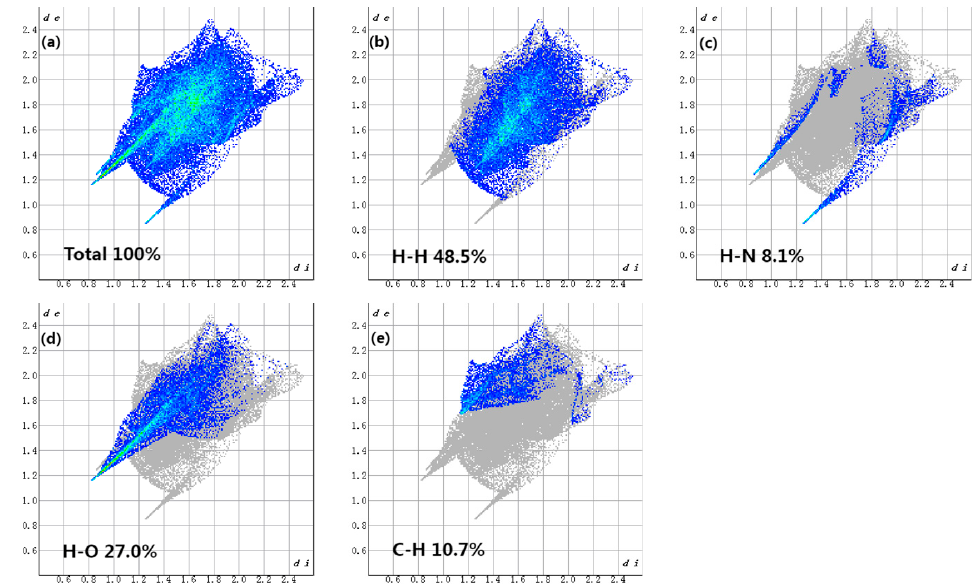
Figure 13. The 2D fingerprint plots of the overall proportion of various hydrogen bond types of MET–DBS highlighted close contacts from H atom to H, N, O, and C atoms.